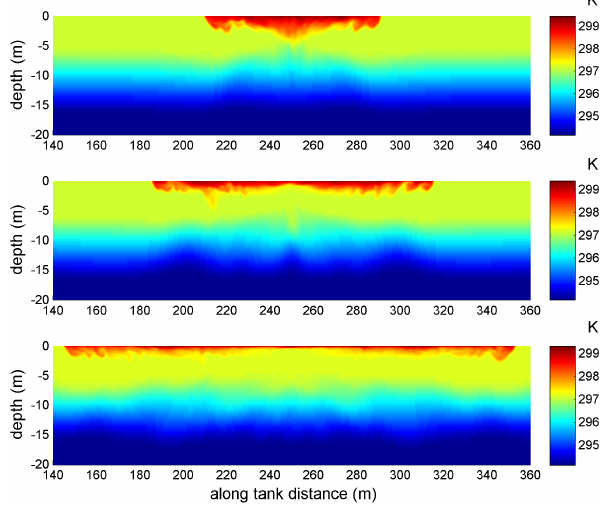
Figure 7. Top view of the along-tank ( x ) velocity (in ms − 1 ) show- ing the evolution of the density current front and the fragmentation (surface “lines”) that occurs due to the interaction of the density current with the ambient stratification. Top: after time 300s, mid- dle: after 1500s, bottom: after